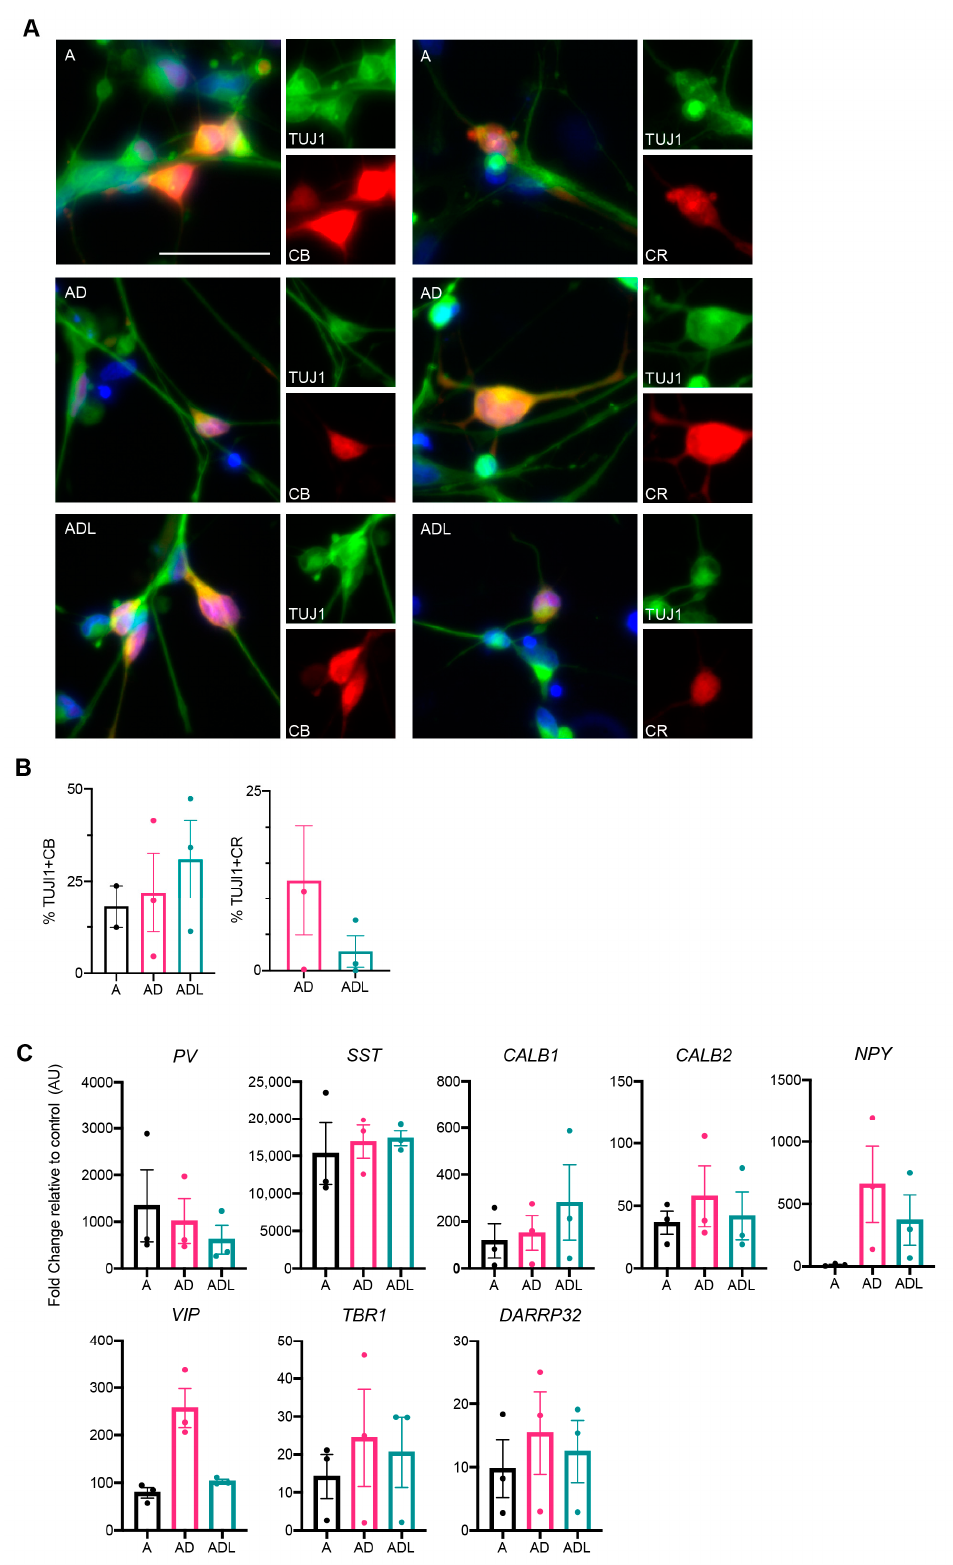
Figure 3. Characterization of the interneuron subtypes generated with A, AD and ADL conversion cocktail at day 25. ( A ) Immunocytochemistry of reprogrammed subtype-specific interneurons. ( B ) Quantification of TuJ1/CB (calbindin) and TUJ1/CR (calretinin) double positive cells at day 25 ( n = 2 for A, n = 2–3 for AD and n = 2–3 for ADL). ( C ) RT-qPCR of subtype-specific lineage markers. Scale bar represents 50 μ m.